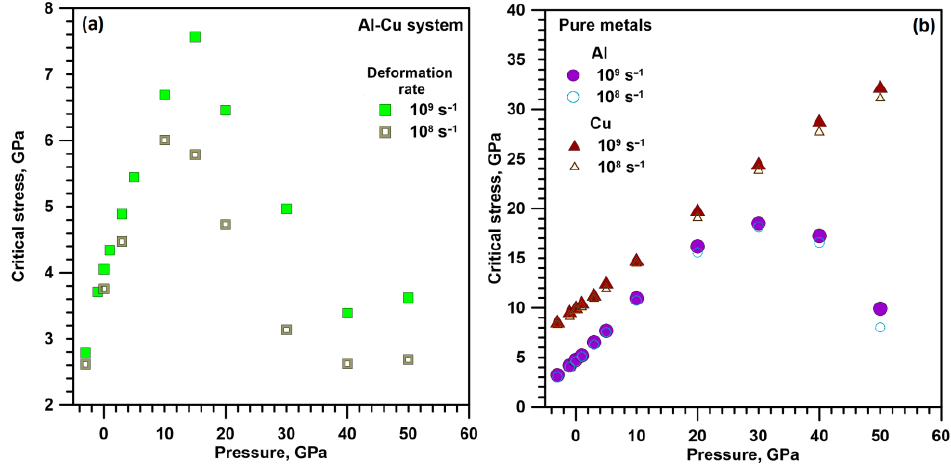
Figure 3. Critical shear stresses of the plasticity initiation in the bisystem ( a ) and pure metals ( b ) as functions of pressure for two strain rates; the temperature is 300 K.